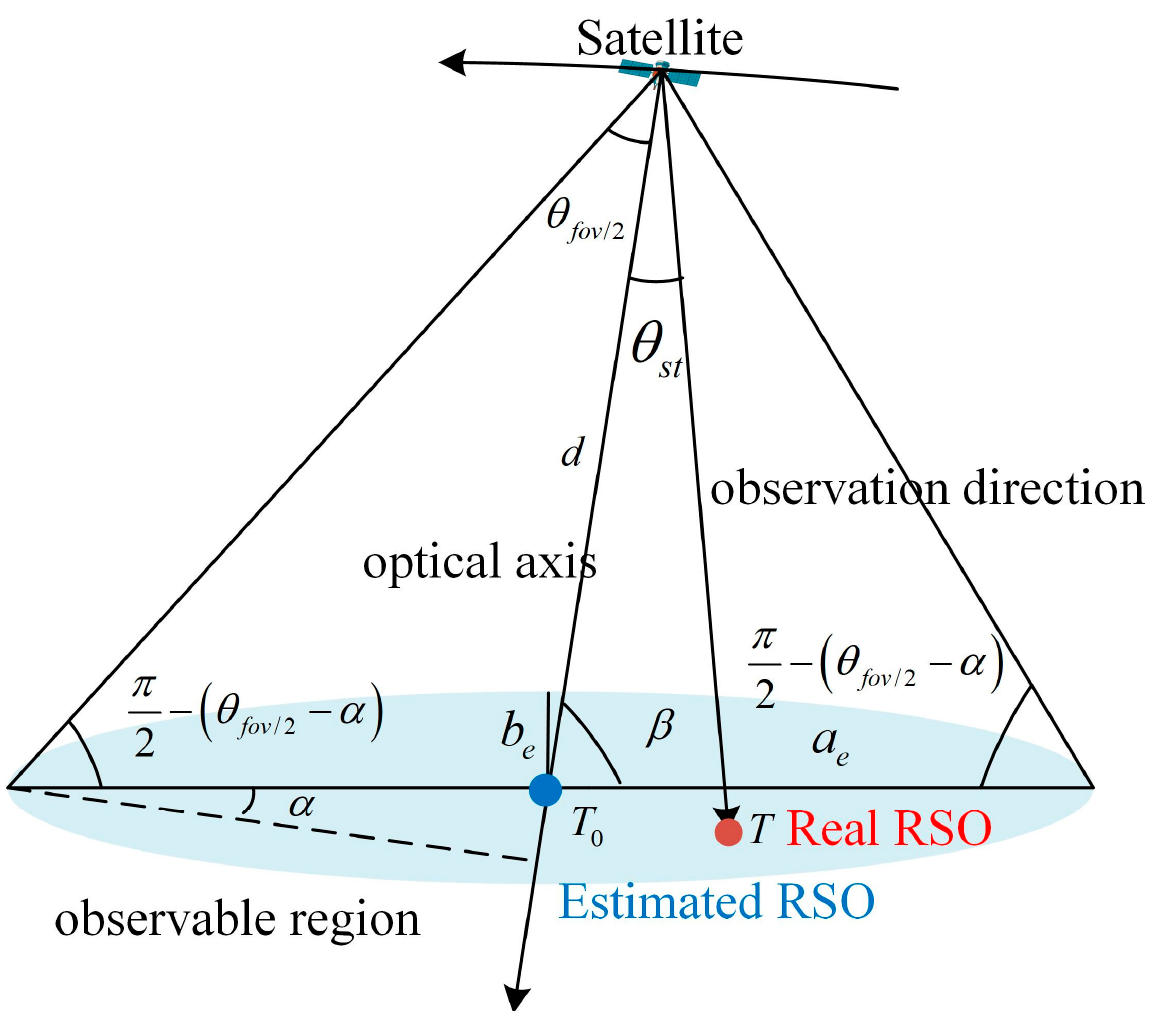
Figure 2. Schematic diagram of the observable region of the star tracker on the RSO orbit plane. When θ st is smaller than θ fov /2 , the real RSO is in the observable region that can be captured by the star tracker. Moreover, the observable region S can be expressed as: